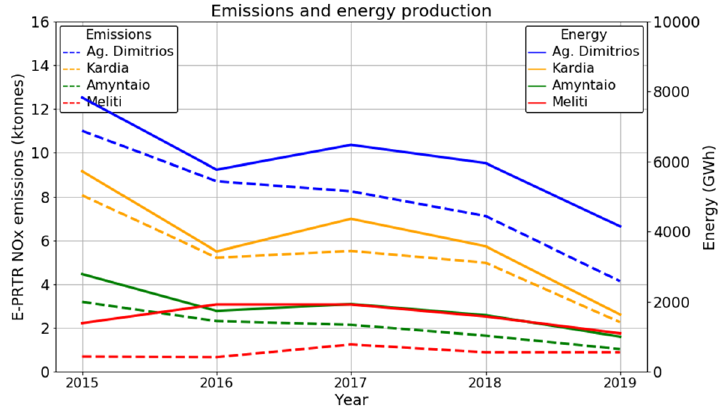
Figure 2. Annual NO x emissions for the four power plants in the target region as reported by E-PRTR between 2015 and 2019 (dashed lines) and the annual energy reported by the Energy Exchange Group (solid lines) for the four power plants; Ag. Dimitrios (blue), Kardia (orange), Amyntaio (green) and Meliti (red).